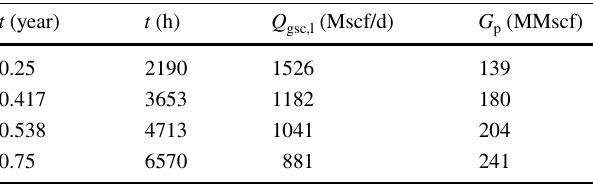
Table 3 Results of calculations of long-term post-fracturing produc- tion profile; early time linear flow transient state